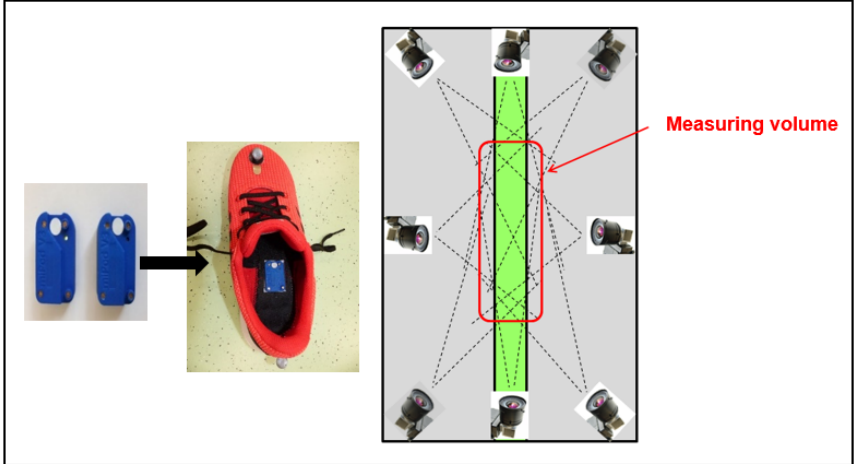
Figure 1. Setup: Inertial sensors and athletic shoes ( left ); measurement volume limited through cameras of MC ( right ).